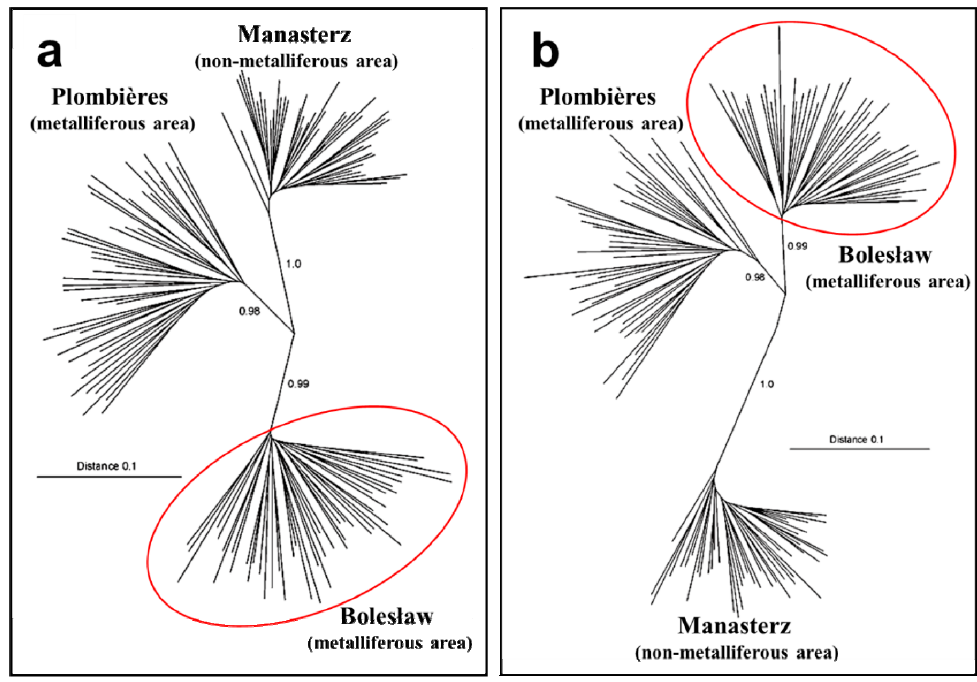
Figure 4. The unrooted neighbor-joining (NJ) trees based on AFLP data: ( a ) a Kpn I ⁄ Mse I methylation-insensitive enzyme combination and ( b ) Acc 65I/ Mse I methylation-sensitive enzyme combination from 136 individuals of A. maritima from two metalliferous populations—a zinc–lead waste heap from Boles ł aw in Poland (red oval) and a zinc–lead slag heap from Plombières in Belgium—as well as one non-metalliferous population—Manasterz in Poland (dry and semi-dry meadow). The numbers above branches denote bootstrap values, with Nei and Li’s genetic distances (based on Abratowska et al., 2012 [23], modified).